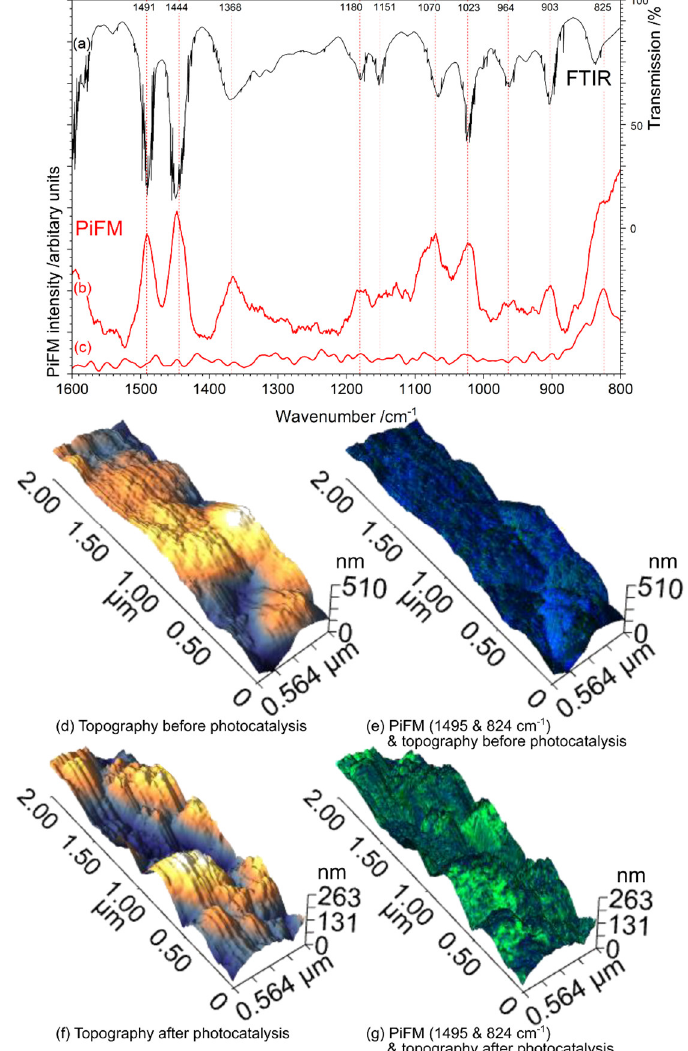
Figure 5. PIFM and AFM data on polystyrene covered TiO 2 films prepared at 5000 rpm. In the uppermost chart, the FTIR transmission spectrum from a polystyrene sample ( a ) is compared with the PiFM spectra obtained from the films before ( b ) and after photocatalysis ( c ). The topography of the polystyrene covered catalyst surface before and after photocatalysis is compared in ( d , f ). In ( e , g ), the local intensities of the signals at 1495 cm − 1 (polystyrene, blue) and 824 cm − 1 (TiO 2 , green) are mapped onto the